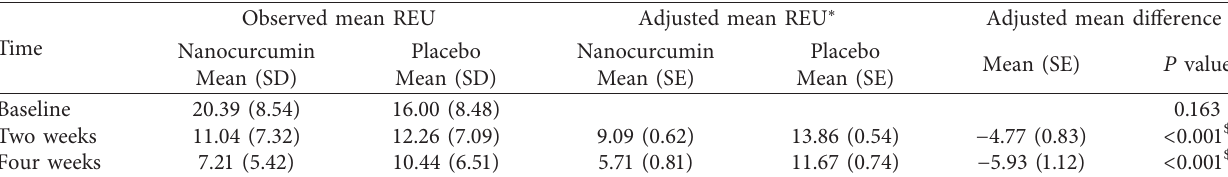
Table 2: Comparison of the REU scores at baseline and at two and four weeks.